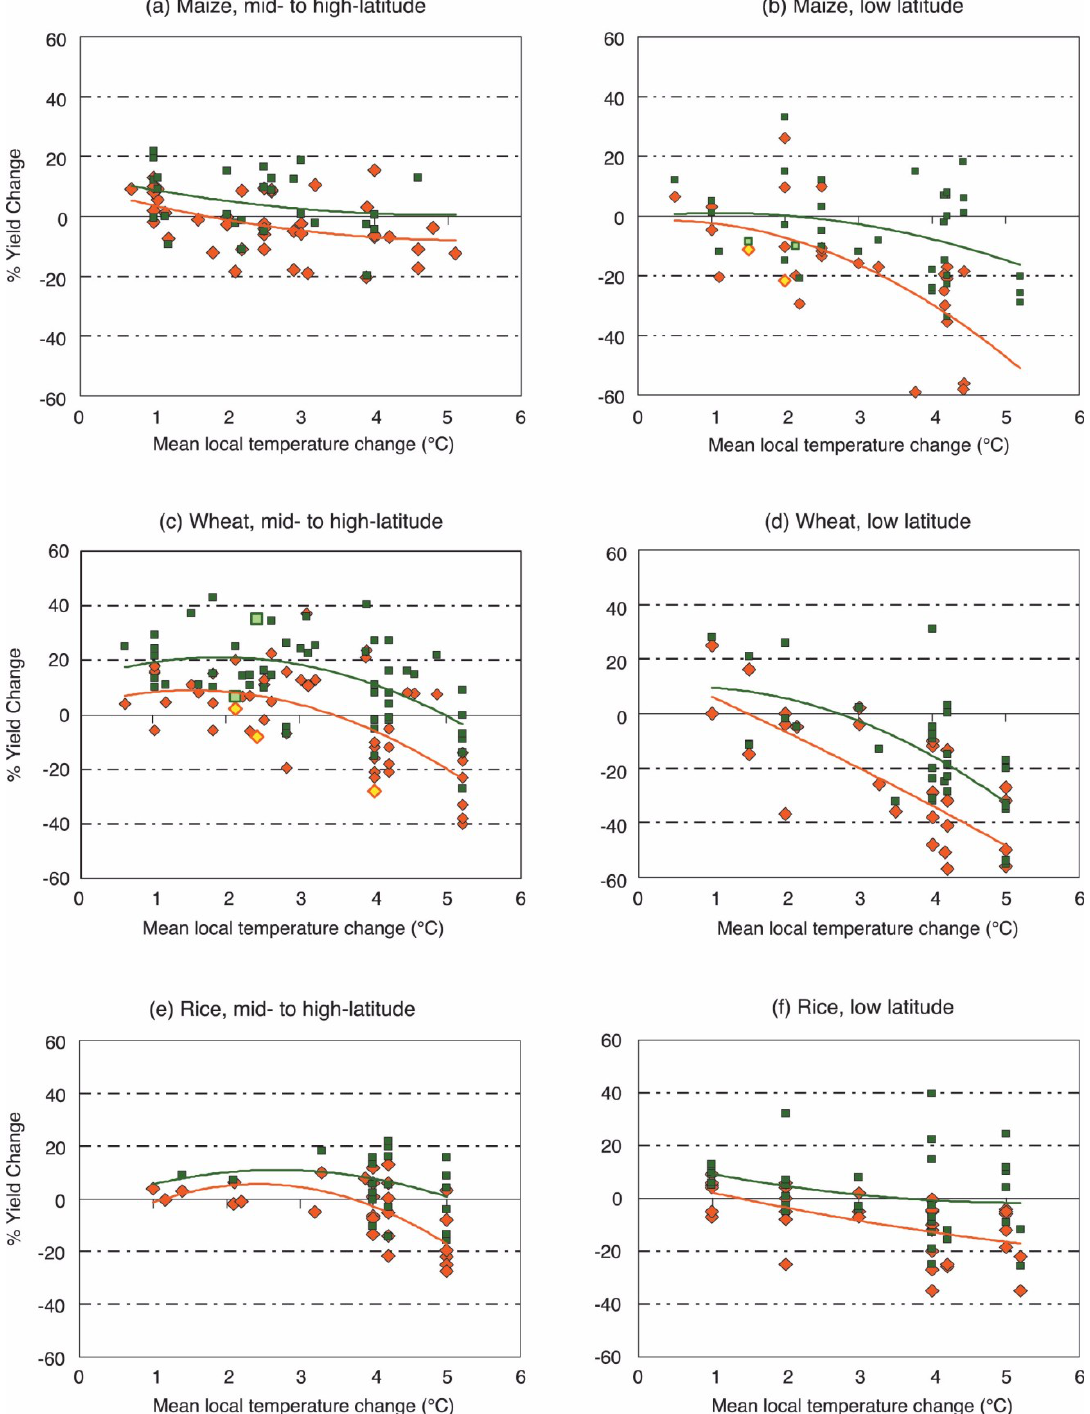
Figure 6. Expected sensitivity of cereal yields to climate change. The upper (green) trend lines are for yields with adaptations to address climate change; the lower (orange) trend lines are for yields without adaptations to address climate change. The boxes are individual data points for yields with adaptations, the diamonds for yields without adaptations. Figure 5.2 from